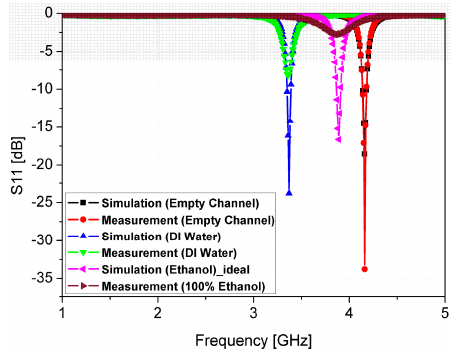
Figure 9. Comparison of simulated and measured S-parameters of the proposed microfluidic CSRR-loaded patch using air (empty channel), DI water, and 100% ethanol.